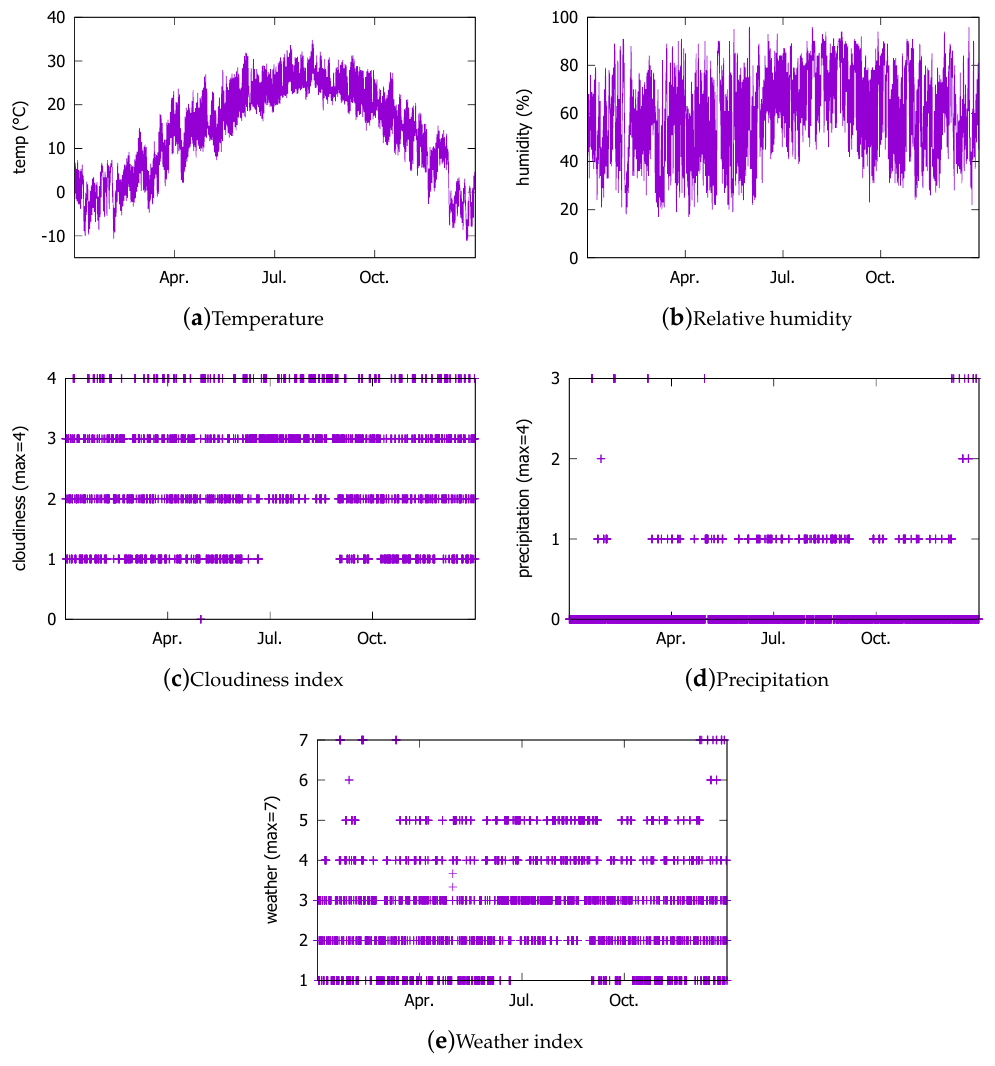
Figure 5. Some weather forecast data items from KMA in